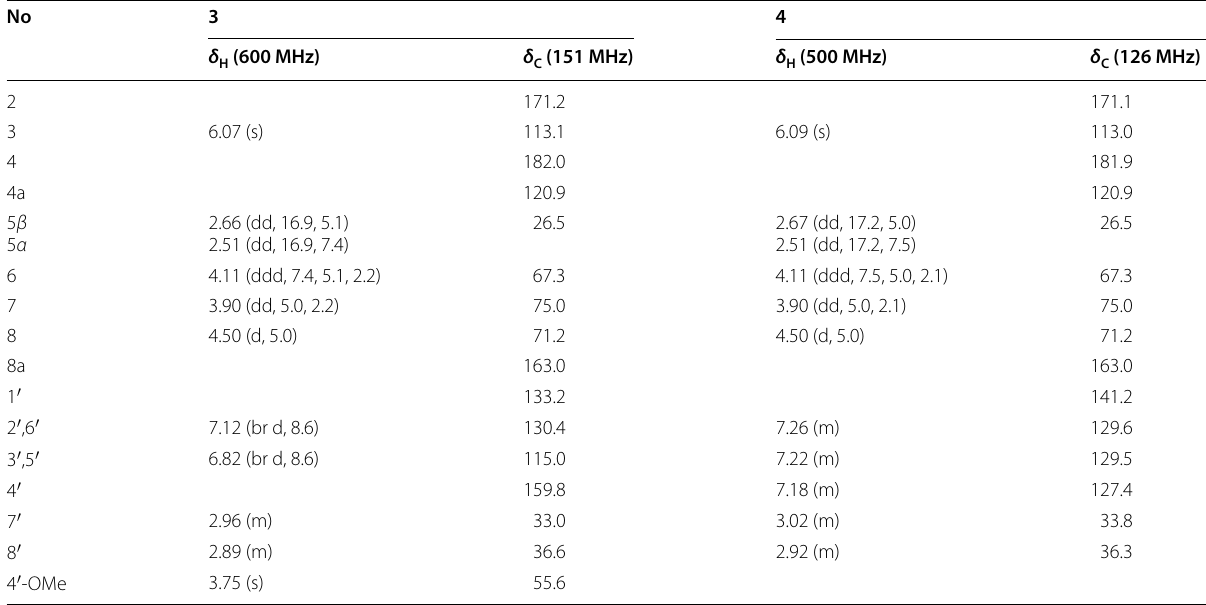
( δ in ppm, J in Hz) 4